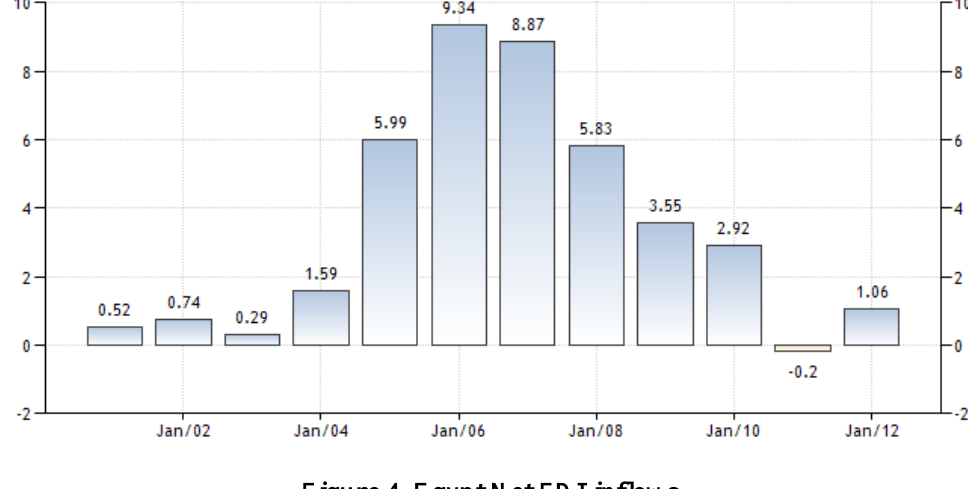
Figure 4. Egypt Net FDI